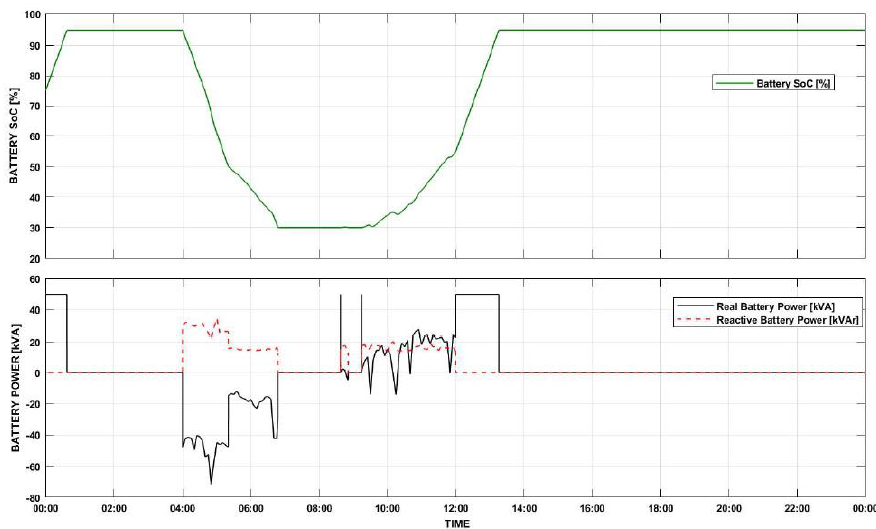
Figure 21. Performance of 150 kWh BESS during an 8-h power cut at 4 a.m.